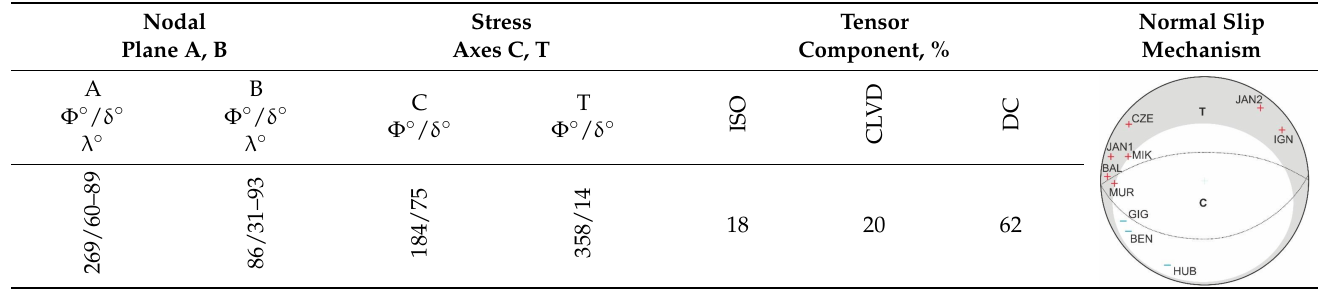
Table 2. Parameters of the focal mechanism of the tremor of 8 November 2018. Nodal Plane A, B